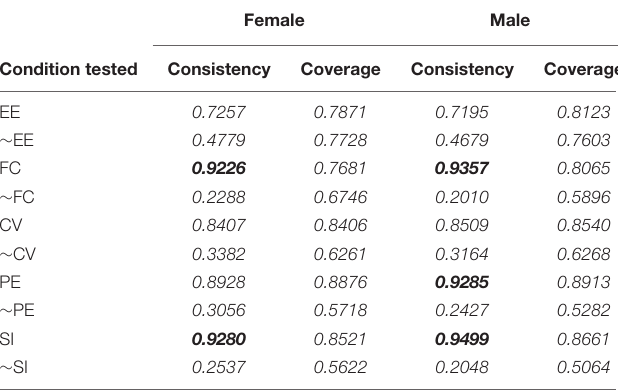
TABLE 7 | Necessity